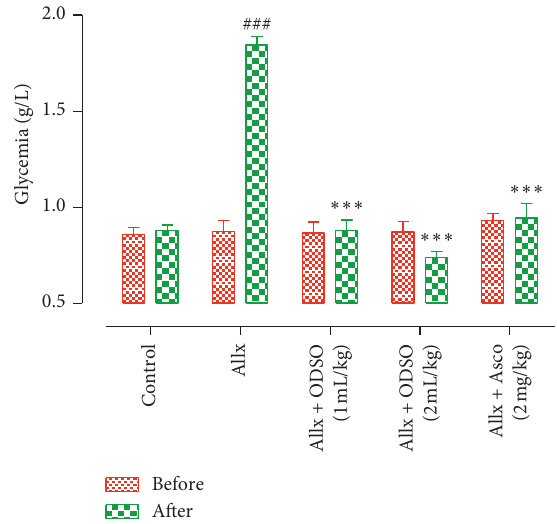
Figure 3: Effect of oral administration of the ODSO and the ascorbic acid on blood glucose level before (day 1) and after (day 7) Allx intraperitoneal injection in mice. The values are presented in mean ± SEM. n � 6-10, ### P < 0 . 001 compared to the control group and ∗∗∗ P < 0 . 001 compared to the Allx control group.